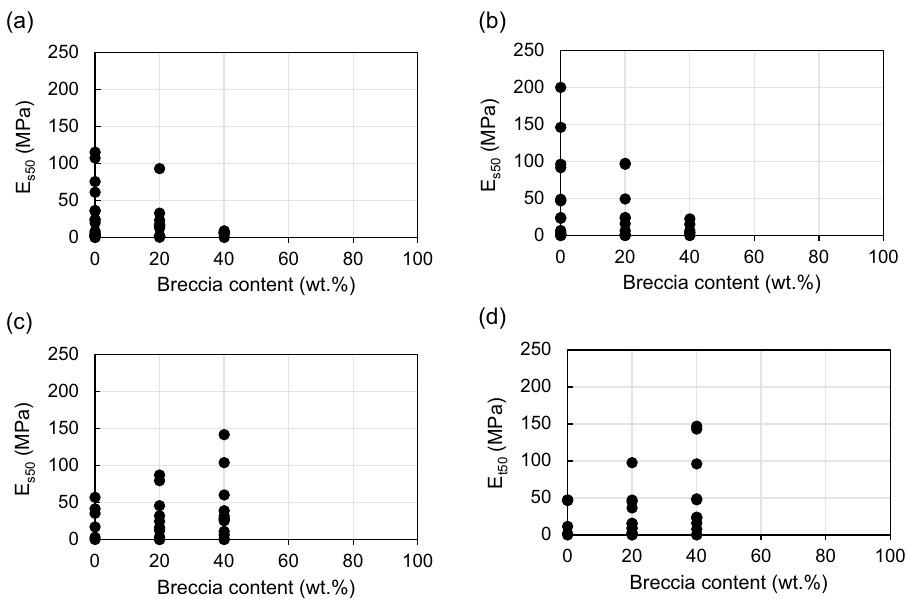
Figure 13. Relationship between E (E s50 and E t50 ) and breccia content classified based on clay contents of 50 wt.%. (a) E s50 and (b) E t50 show a proportional relationship with the breccia content in specimens for clay content of ≥ 50 wt.%. (c) E s50 and (d) E t50 show an inverse relationship with breccia content for clay contents of < 50